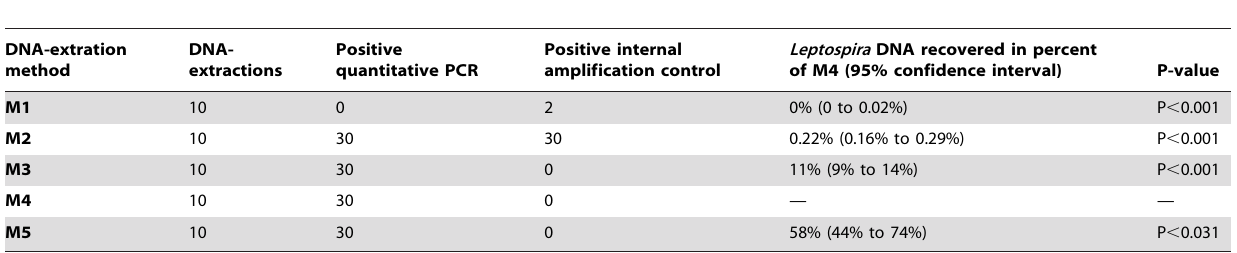
Table 1. Effectiveness of DNA extraction method, M1–M5 in recovering Leptospira DNA from BACTEC TM anaerobic Plus.